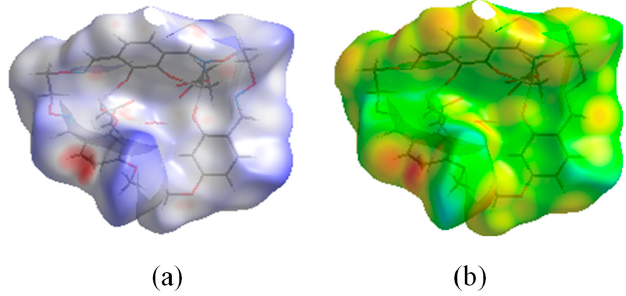
Figure 6. Hirshfeld surfaces mapped with ( a ) d norm and ( b ) d i of the Zn II coordination compound. The surfaces are depicted as transparent to allow visualization of the molecule structure.